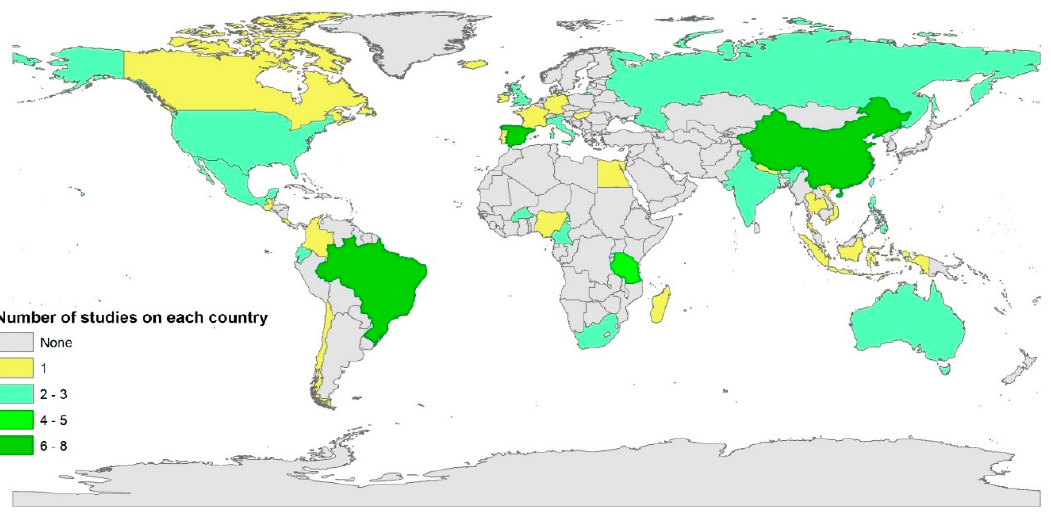
Figure 4. Geographical scope of the studies by country from 2010 to 2019.